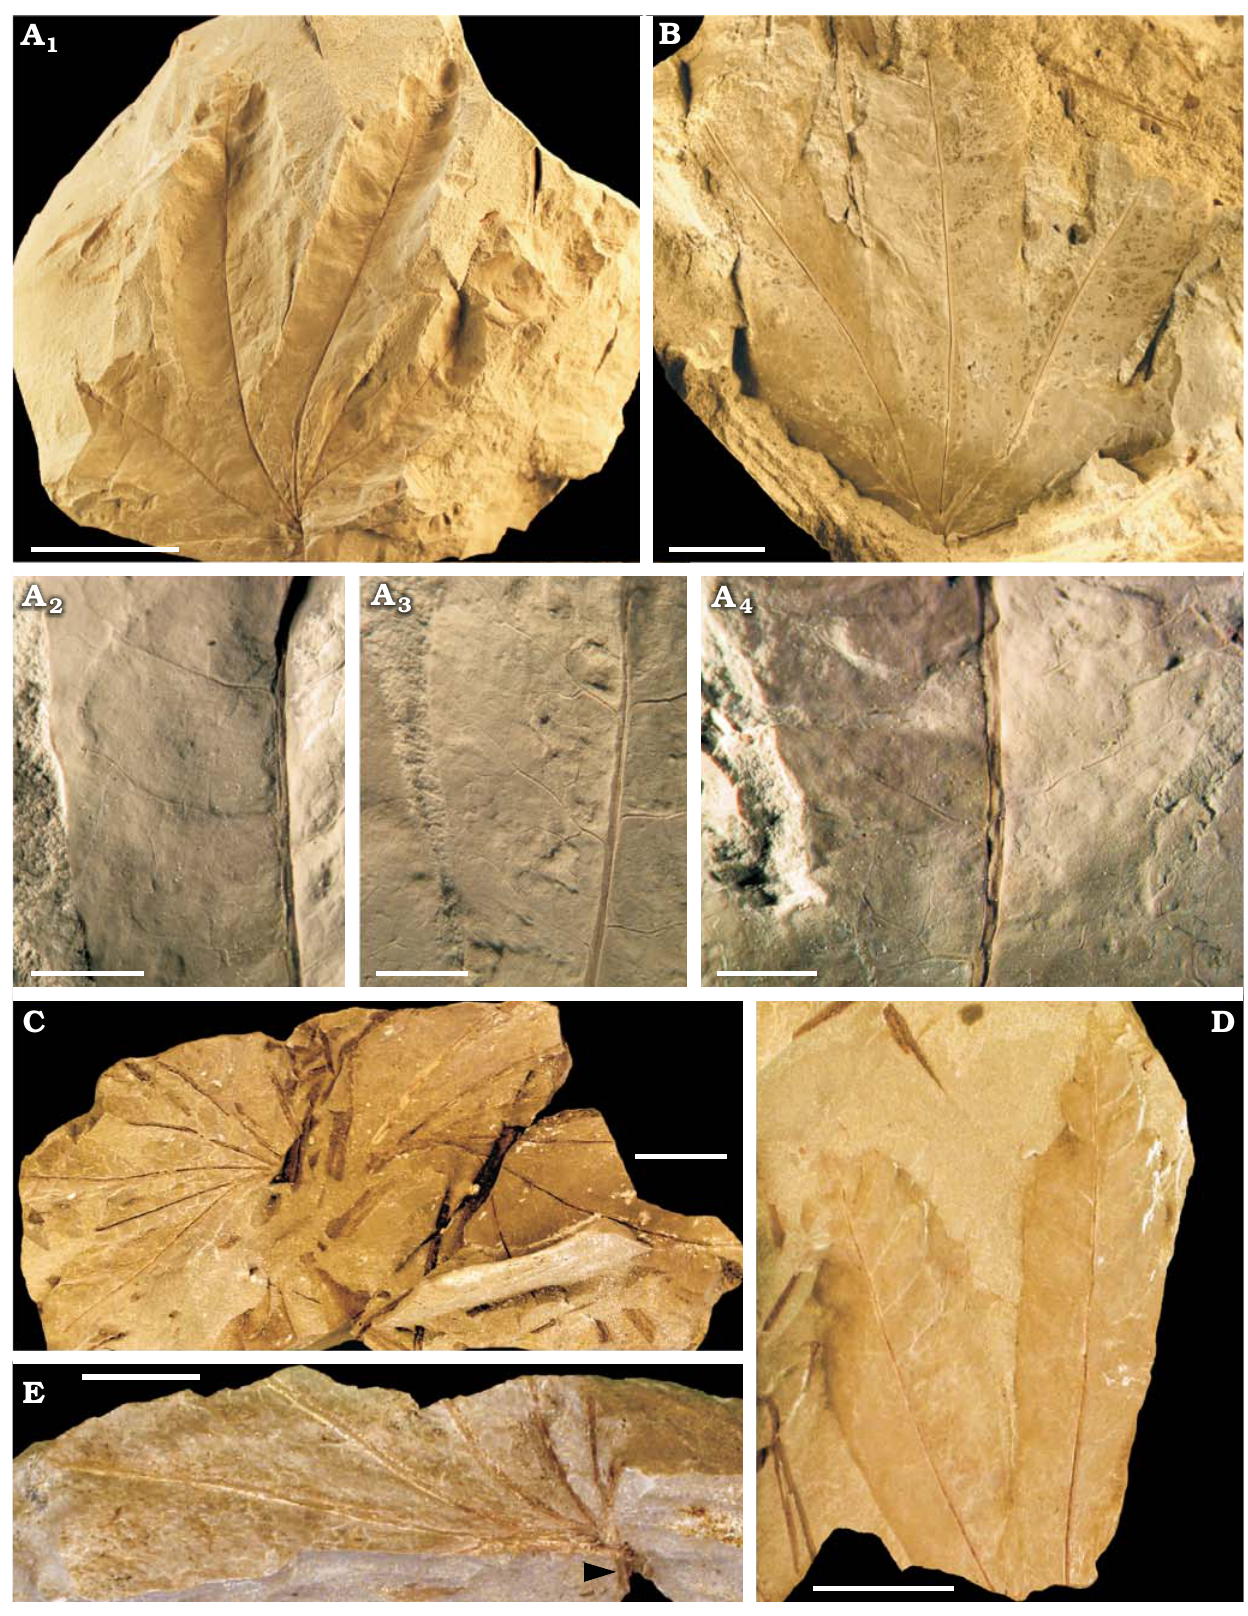
Fig. 4. Dipterid fern Dictyophyllum menendezi sp. nov. from Cortaderita Formation (Ladinian, Middle Triassic) of Barreal-Calingasta, San Juan Province, Argentina. A . PBSJ 832, general view of the frond (A 1 ), details of secondary and tertiary veins, and areoles (A 2 , A 3 , A 4 ). B . PBSJ 833. C . PBSJ 840. D . PBSJ 836. E . PBSJ 843, sample with apical part of petiole preserved (arrow). Scale bars: A 1 , D, 20 mm; B, C, E, 10 mm; A 2 , A 3 , A 4 , 5